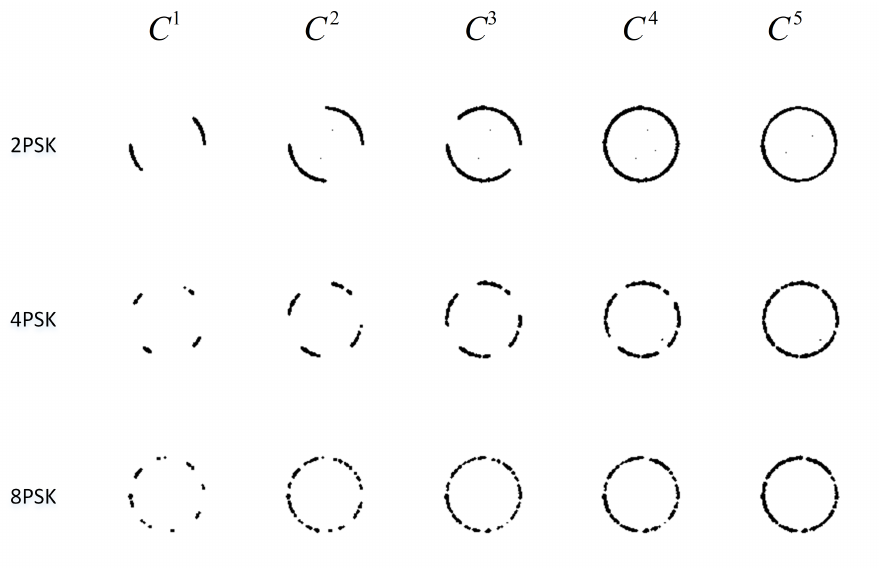
Figure 2. The CD sequences of three PSK